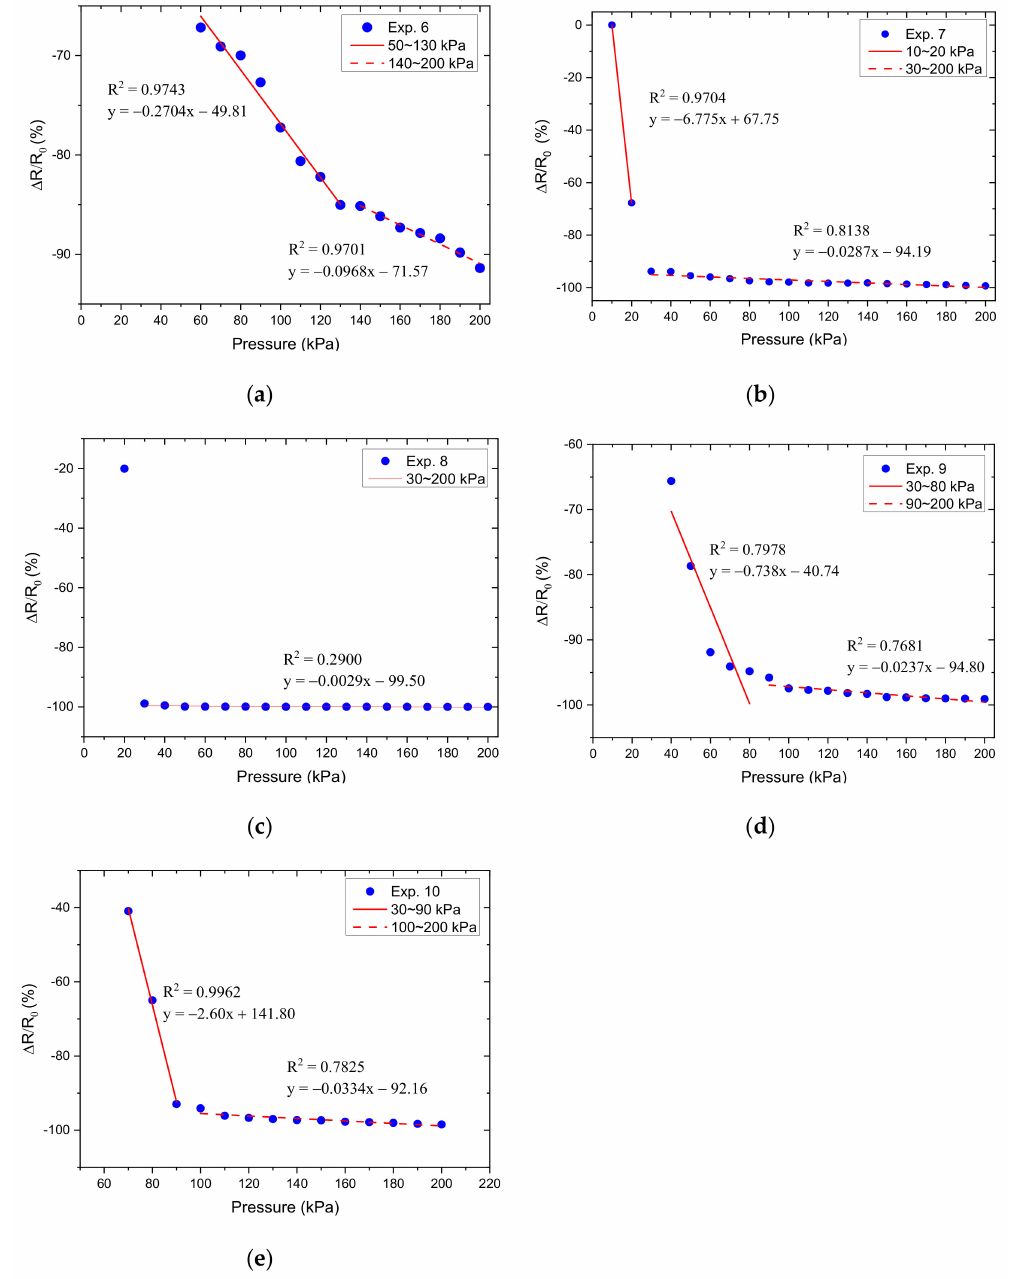
Figure 19. The relative resistance change as a function of applied pressure for different grid microstructures in which ( a – e ) corresponds to experiments